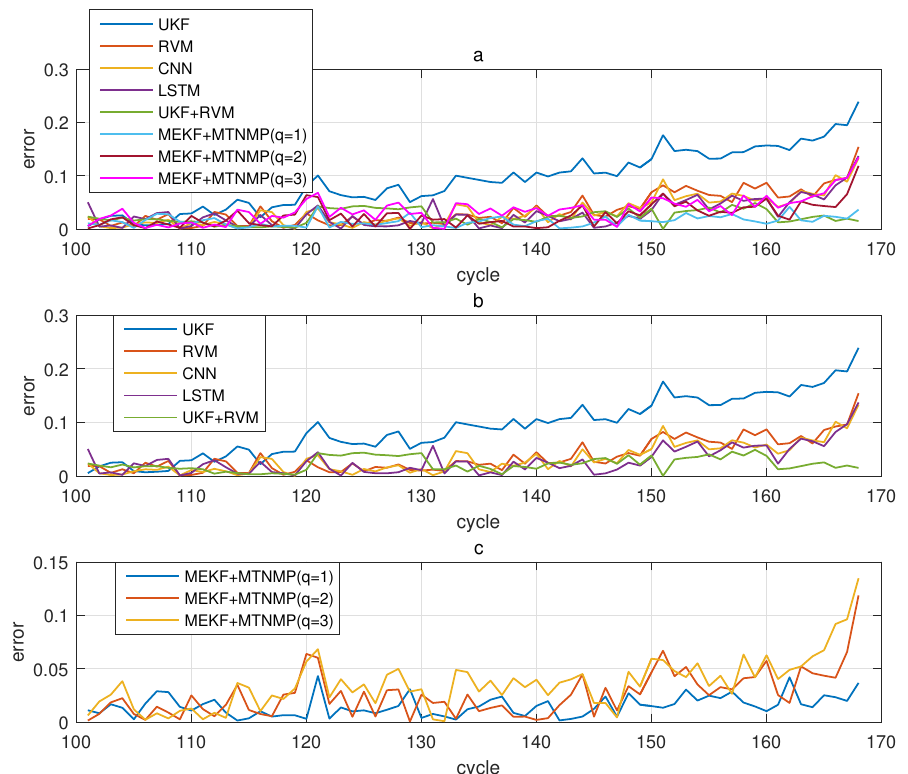
Figure 7. The simulation error diagram of B0005 predicted from the 100th time. ( a ) is the experimental error of all methods, ( b ) is the error of other methods used for comparison in ( a ), and ( c ) is the error of the method proposed in this paper in ( a ).